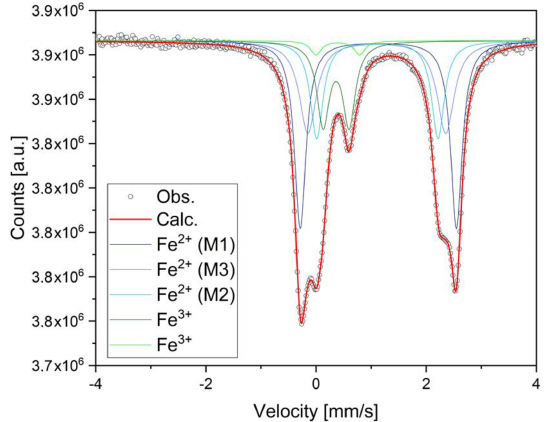
Figure 8. Fitted 57 Fe Mössbauer spectrum for